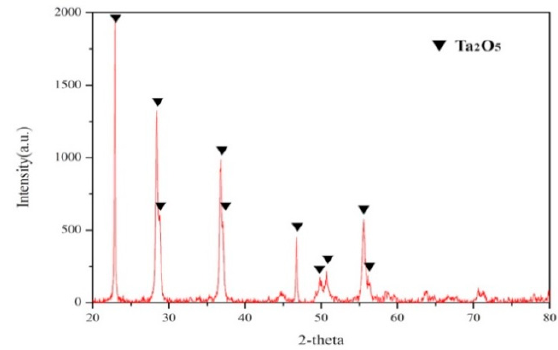
Figure 16. The XRD patterns for Ta 2 O 5.